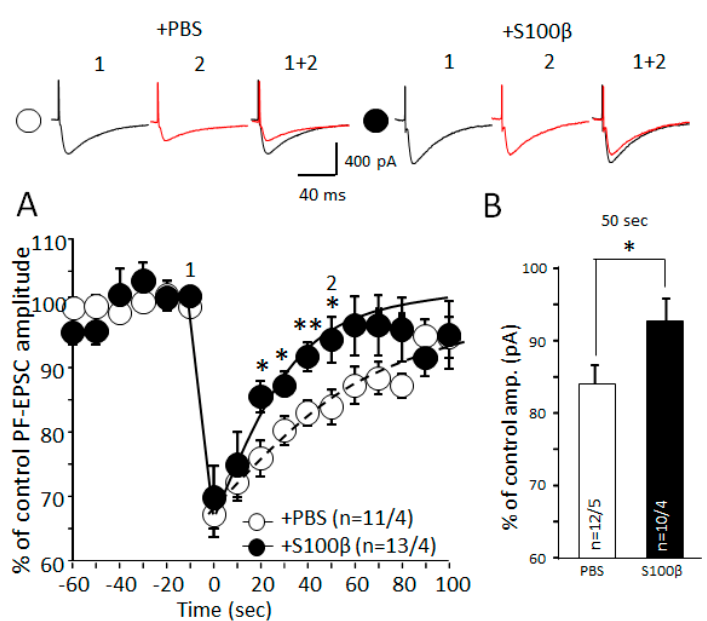
Figure 7. S100 β disrupts the depolarization induced suppression of excitation (DSE) at PF–PC synapses. ( A ) Average time course diagram of PF-EPSC amplitudes before and after depolarization. The amplitudes of PF-EPSC were normalized to values before depolarization. The numbers (n) of tested PCs and animals (PCs / animals) are indicated in the graph. Dotted and black lines indicate the double waveform model fit for PBS and S100 β injected groups, respectively. Representative PF-EPSC traces from PCs from PBS- and S100 β -injected mice are shown above the diagram. Time points: before (1) and 50 s after (2) depolarization. ( B ) PF-EPSC amplitudes 50 s after depolarization. In comparison with PBS-injected areas, the PF-EPSC amplitude was significantly bigger in S100 β injected areas. * p < 0.05.